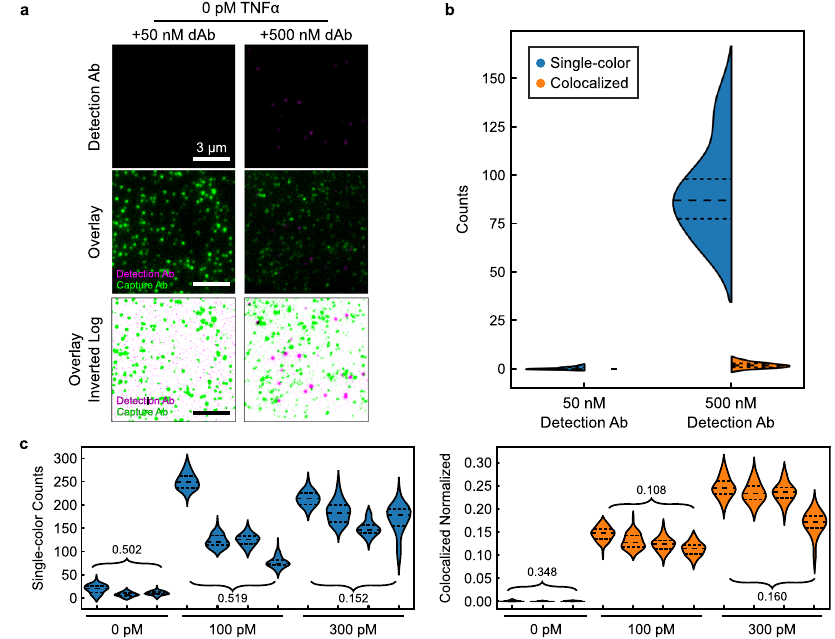
Fig. 2 | Colocalization minimizes background from excess detection antibody. a Single-color fl uorescence images of dAb only (top), two-color images of cAb and dAb (middle), and log-scale inverted composite images of two-color detection (bottom)intheabsenceofTNF- α andwith50nM(left)or500nM(right)dAb.Dark spotsinthebottompanelsrepresentcolocalizedsignalfromthetwo fl uorophores. b Distributions of absolute single-color and colocalized counts across 16 fi elds of